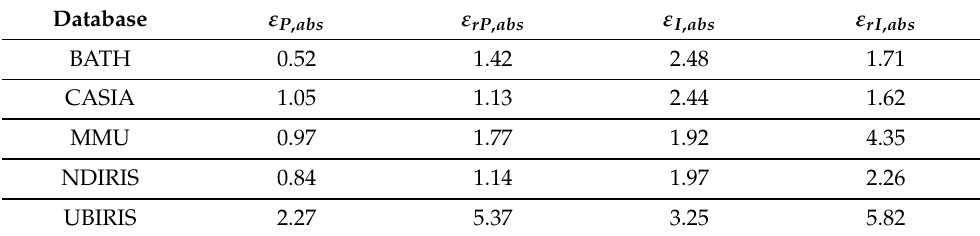
Table 3. Errors of final iris parameters detection,